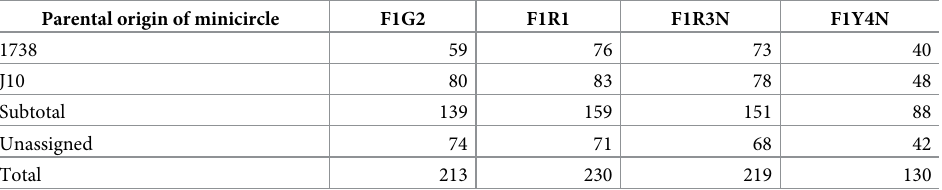
Table 3. Parental origin of minicircles in hybrid